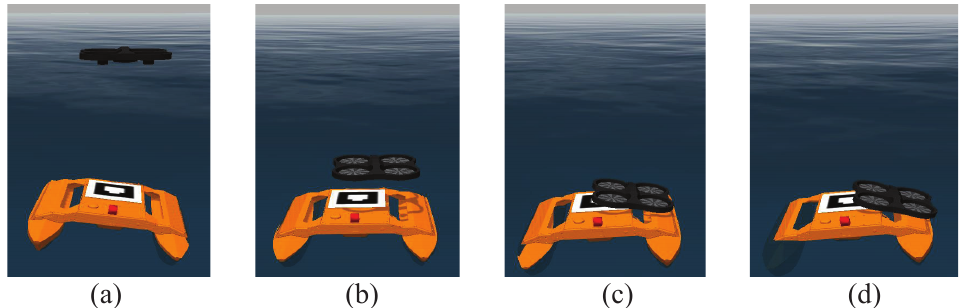
Figure 12. USV roll motion − failure situation of UAV landing.The UAV did not respond to the attitude change of the USV, and the landing process was a vertical landing ( a – c ). When the USV roll angle changed greatly, the UAV collided with the side of the USV, resulting in the failure of the UAV landing ( c , d ).